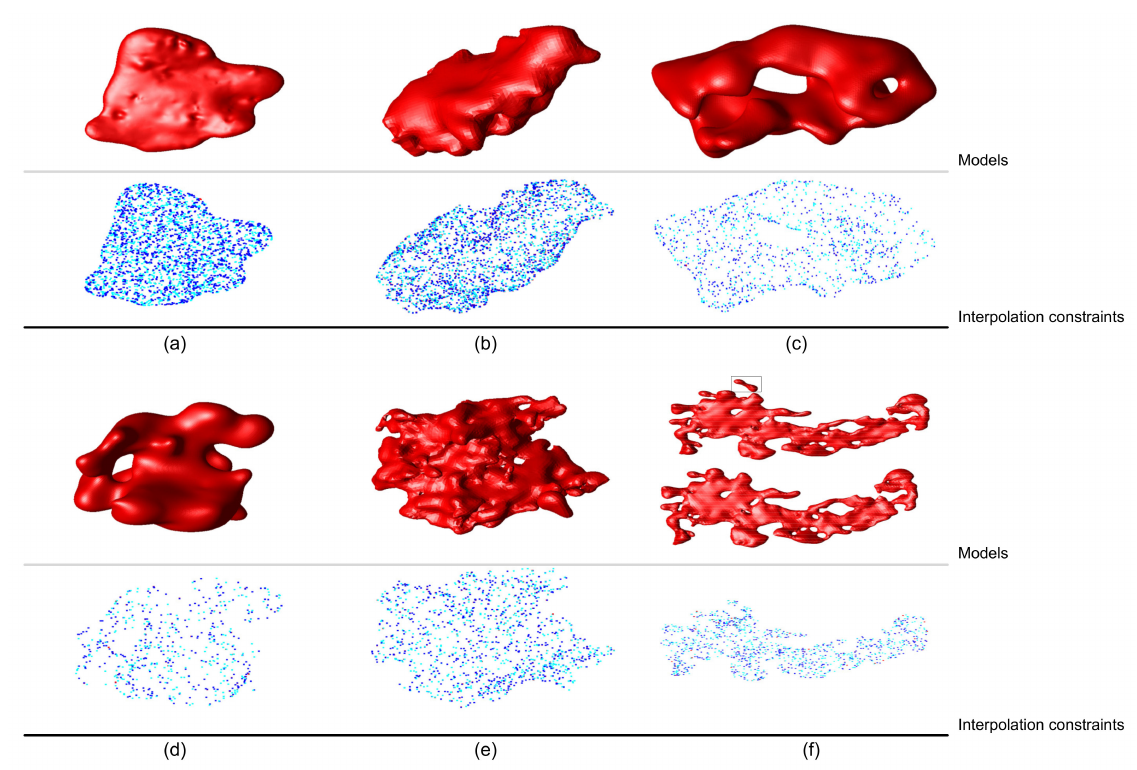
Figure 6. The reconstruction results of six geological body models based on the interpolation points using the signed marching cubes method. Among the interpolation constraints, cyan points repre- sent the interpolation constraints exterior of the isosurface, blue points represent the interpolation constraints interior of the isosurface, and red points represent the interpolation constraints on the isosurface. ( a – f ) are six reconstructed models and the corresponding interpolation constraints.